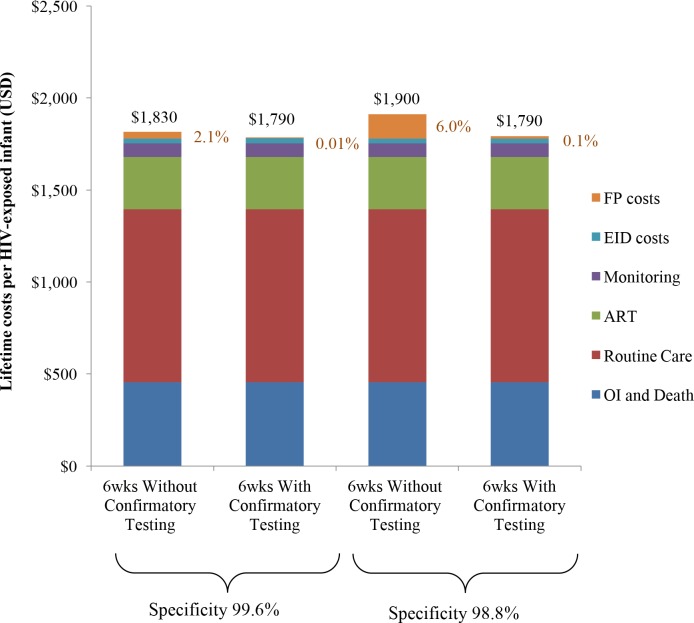
Total lifetime costs per HIV-exposed infant by EID strategy.Columns include components of lifetime total costs per HIV-exposed infant tested: routine HIV care, CD4 and HIV viral load monitoring, OIs and end-of-life care, ART, EID costs, and false-positive costs. EID programme costs are shown in blue and comprise 2%–3% of lifetime costs, as shown previously [21]; false-positive costs are shown in orange and are made up of all component costs acquired for HIV-infected infants other than OI costs. ART, antiretroviral therapy; EID, early infant diagnosis; FP, false-positive; OI, opportunistic infection.